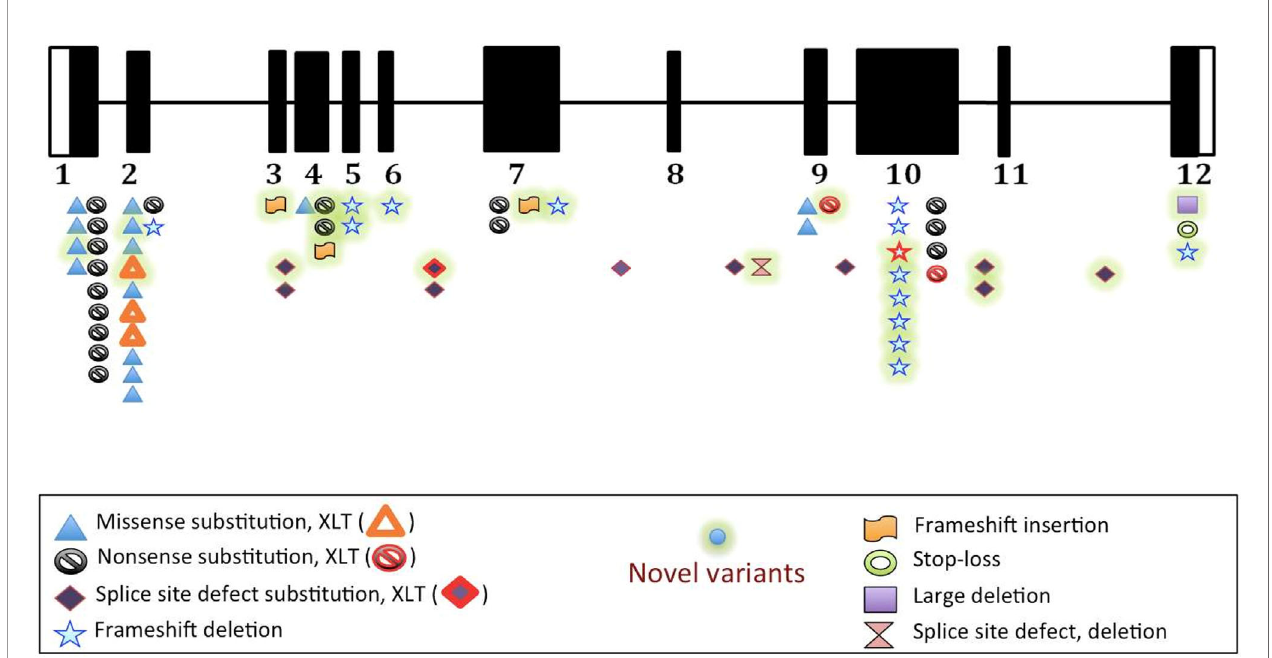
FIGURE 3 | Distribution of variants on various exons, and intervening sequences of WAS gene in study population